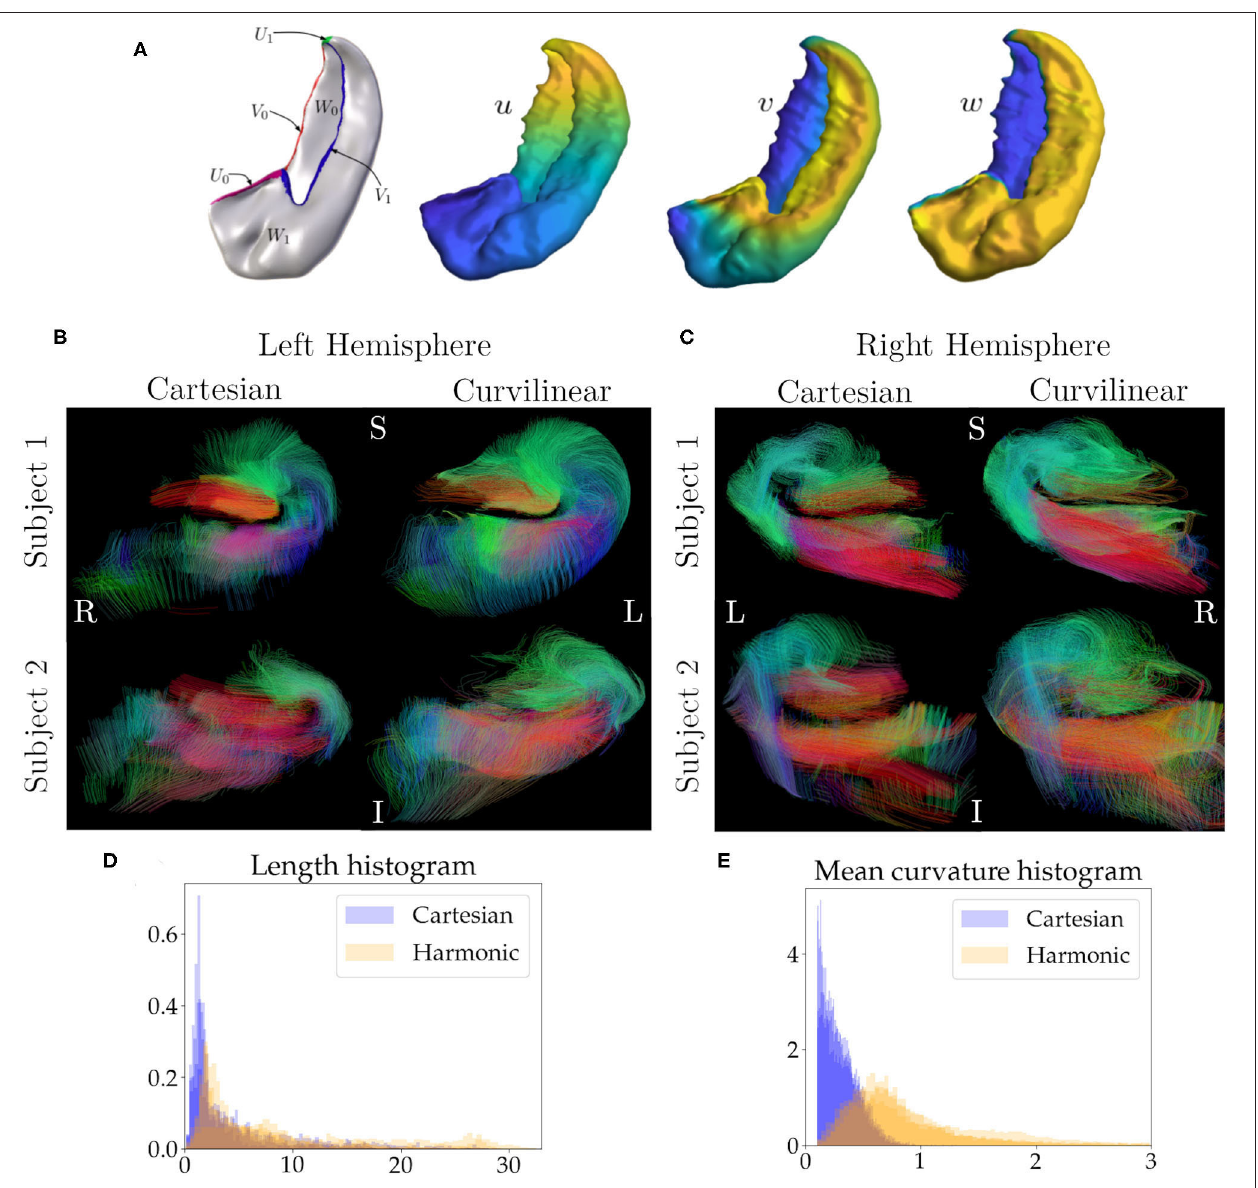
FIGURE 4 | In (A) , we see the boundary conditions and the harmonic coordinates for the hippocampus. For example, to solve for coordinate u , U 0 is the source and U 1 is the sink, and Neumann boundary conditions are used for the rest of the hippocampus. An analogous procedure is used to compute the remaining coordinates. In (B) we see tracts in a coronal slice for the hippocampus of two subjects in the left hemisphere. The first column shows tracts generated from using Cartesian coordinates and the second column shows tracts generated from using curvilinear coordinates, (C) is analogous but for the right hemisphere. The seeds in both coordinate systems are identical. In (B,C) , green represents the anterior to posterior direction, red represents right to left, and blue represents inferior to superior. In (D) , we see a histogram for the normalized length distribution for the tracts, overlaid for each hippocampus, here blue is for Cartesian coordinates and orange is for harmonic coordinates, (E) is similar to (D) but for the mean curvature of the